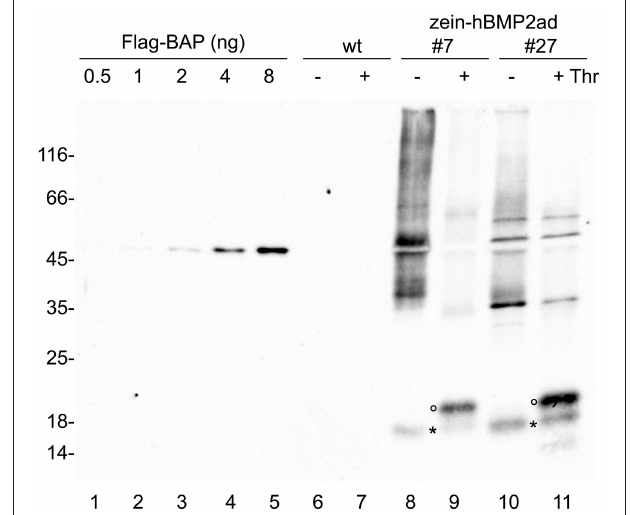
FIGURE 9 | The hBMP2 active domain is efficiently released from zein-hBMP2ad by thrombin cleavage. Twenty-five micrograms of total leaf proteins, extracted in the presence of 2-ME from zein-hBMP2ad transgenic (lines #7 and 27) or wt plants, were incubated for 20h in the presence ( + ) or absence ( − ) of thrombin. The reaction mixtures were analyzed by SDS-PAGE, followed by protein blot using anti-Flag antiserum. hBMP2ad was quantified by comparison with known amounts of the commercial standard protein Flag–BAP (lanes on the left). Empty circles: 20kD hBMP2ad. Asterisks: 18kD fragment of hBMP2ad. Numbers at left indicate the position of the molecular weight markers, in